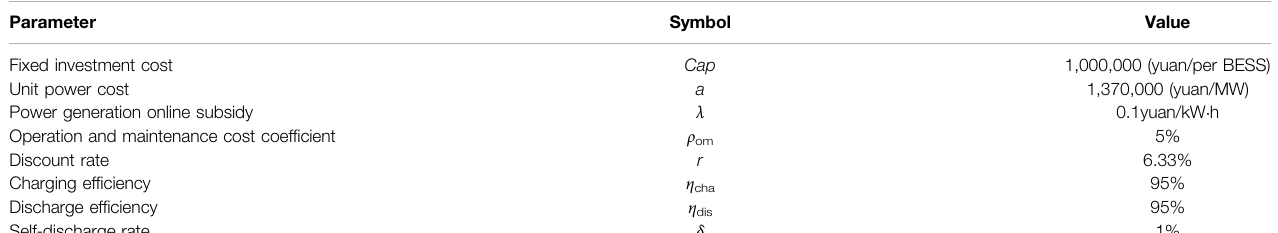
TABLE 1 | Relevant parameters of BESSs.